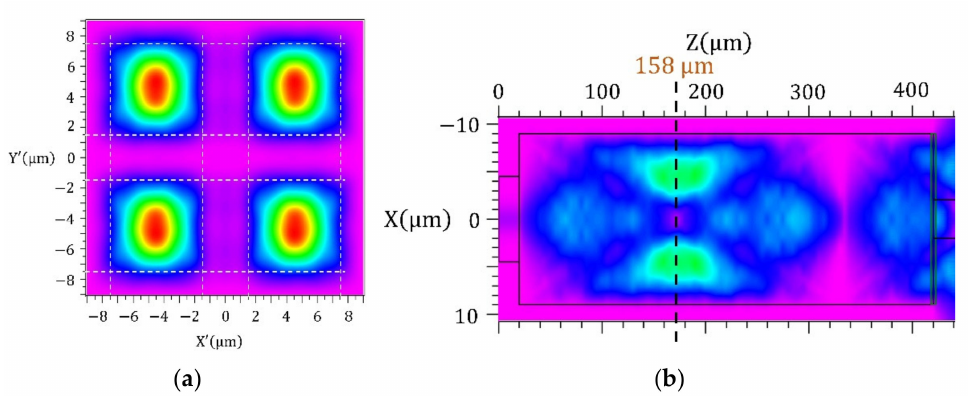
Figure 2. Simulation of electromagnetic wave intensity distribution ( a ) at the end of the MMI part ( b ) along part of the MMI. The white lines indicate the width determination of the interference centres.